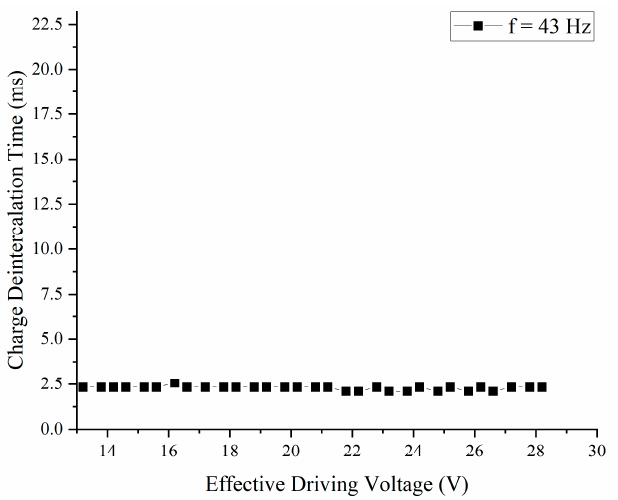
Figure 9. The minimum charge deintercalation time with diverse driving voltage ( V base ).